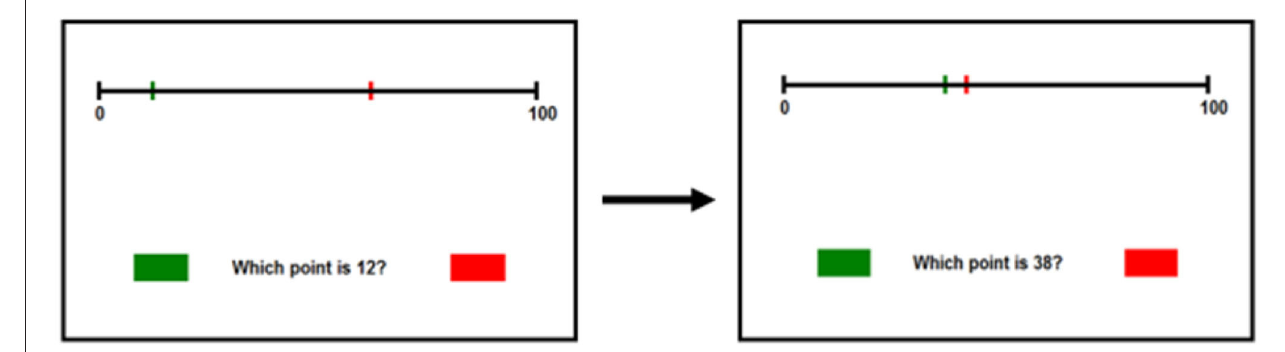
FIGURE 1 | Stimuli for the non-declarative learning condition. The task begins with the red and green lines separated by extensive spatial distance. As the task progresses, the lines become closer together and more difficult to discriminate.